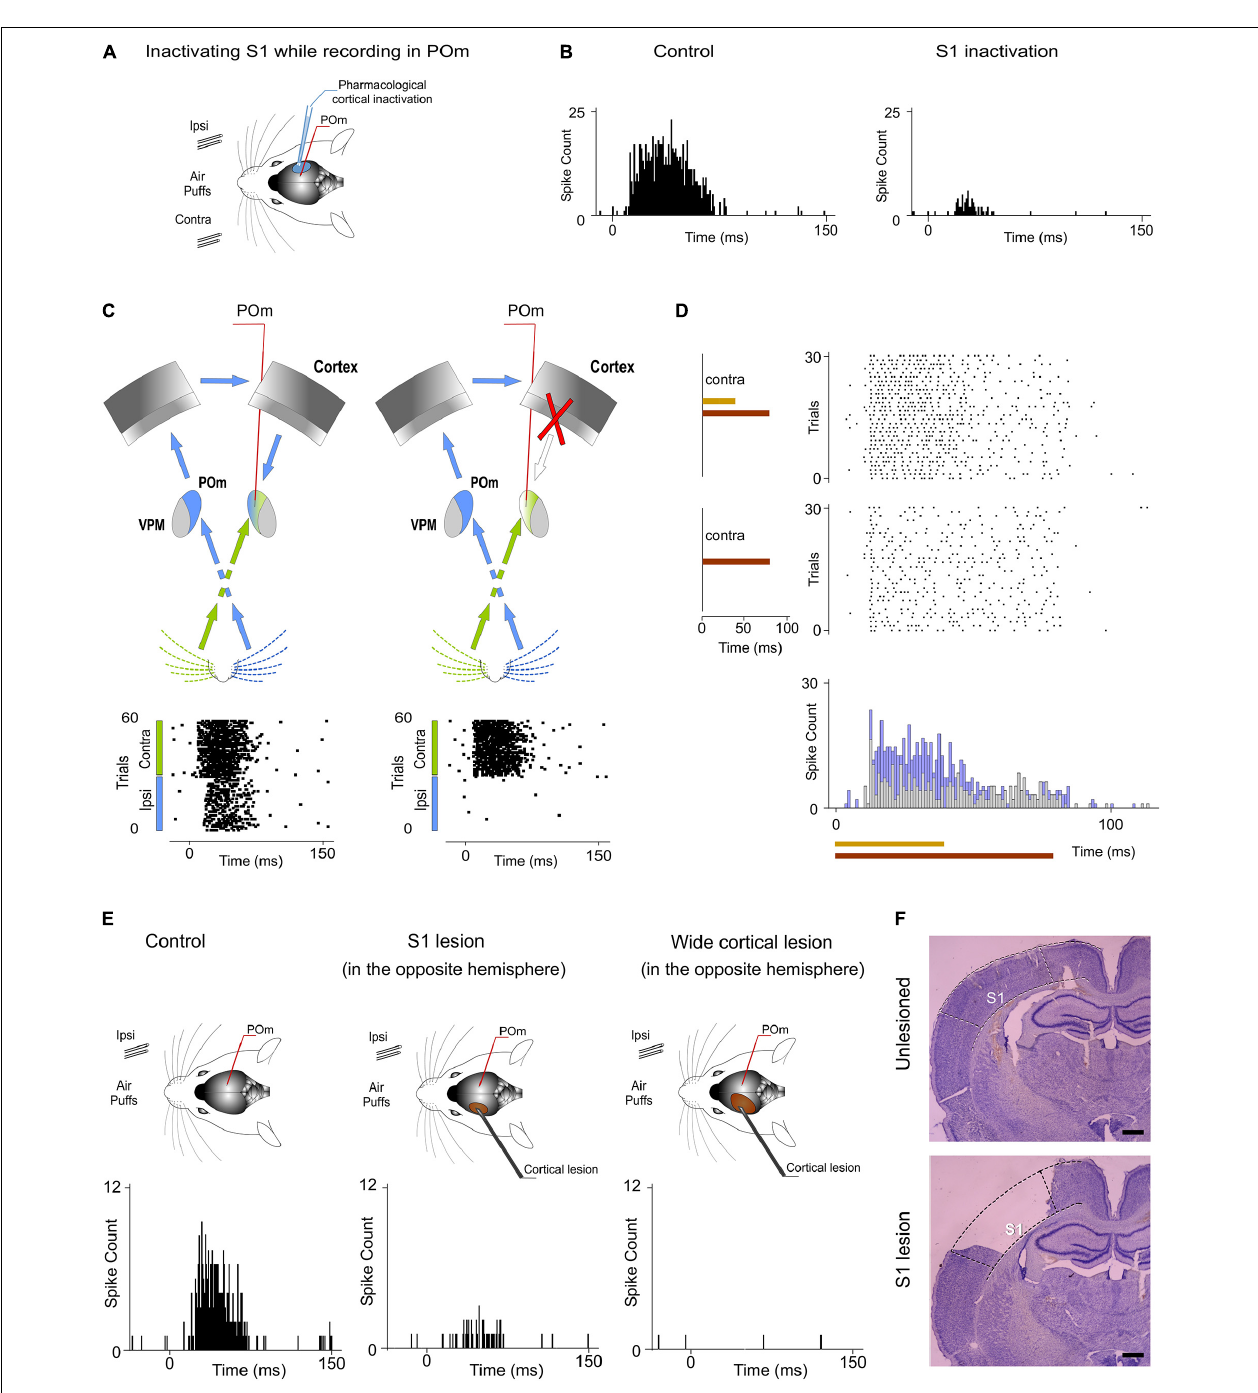
FIGURE 12 | Ipsilateral and contralateral POm nuclei are indirectly connected through the cortex. (A) POm responses were recorded before and after S1 inactivation ( n = 23 multi-units). (B) POm responses to ipsilateral whisker stimulation were almost abolished when S1 was inactivated or lesioned. PSTHs of representative POm responses before and after S1 inactivation. (C) Schematic illustration representing the transmission of contralateral and ipsilateral information to POm. As can be appreciated in the corresponding raster plots, POm response to ipsilateral whisker stimulation was eliminated when the POm-POm loop was interrupted by cortical removal. Note that POm response to contralateral stimulation was still present in this condition. (D) Cortical removal did not affect the capacity of POm to sustain its activity to codify stimuli duration and its capacity to integrate overlapping stimuli as can be appreciated in these POm responses recorded during this condition. (E) Representative POm responses in control, S1 lesion (in the opposite hemisphere) and wide cortical lesion (in the opposite hemisphere) conditions. An almost complete reduction but not a total elimination of ipsilateral responses was produced by the S1 lesion. POm responses to ipsilateral stimulation were completely eliminated only when a wider cortical extension was lesioned. (F) Example histology showing the removal of S1 from a lesioned animal. An unlesioned example is also shown for comparison. Scale bars, 1 mm.